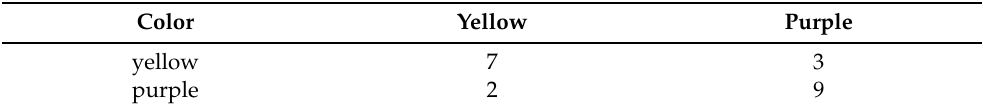
Table 2. Confusion matrix associated with the classifier that rendered the highest area under the receiver operational characteristic curve (AUC).